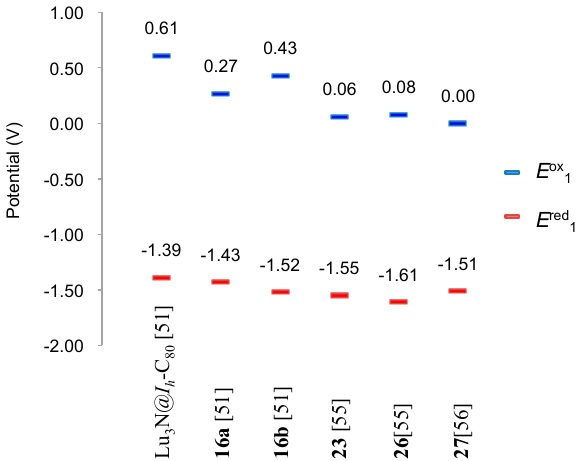
Figure 5. Redox potentials (in V vs. Fc/Fc + ) of pristine and derivatized Lu 3 N@ I h -C 80 .